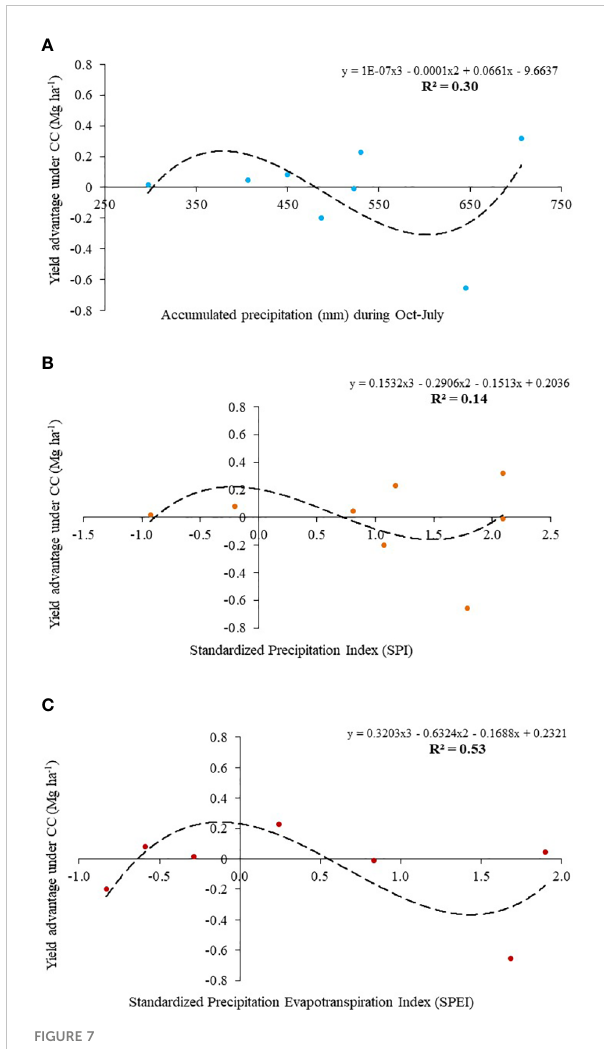
FIGURE 7 Modelling cover crop yield advantage against selected hydroclimatological parameters (A) accumulated precipitation (mm) during Oct-Jul before cover crop planting, (B) SPI, and (C) SPEI values for all site-year ’ s under